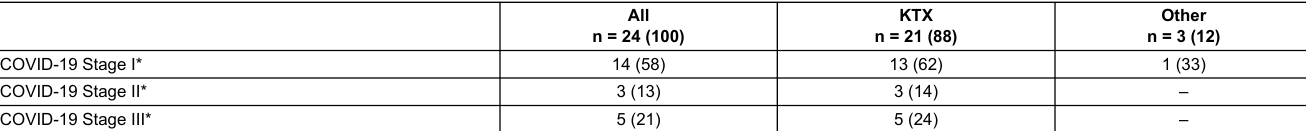
Table 2: COVID-19 stages at time of positive testing for